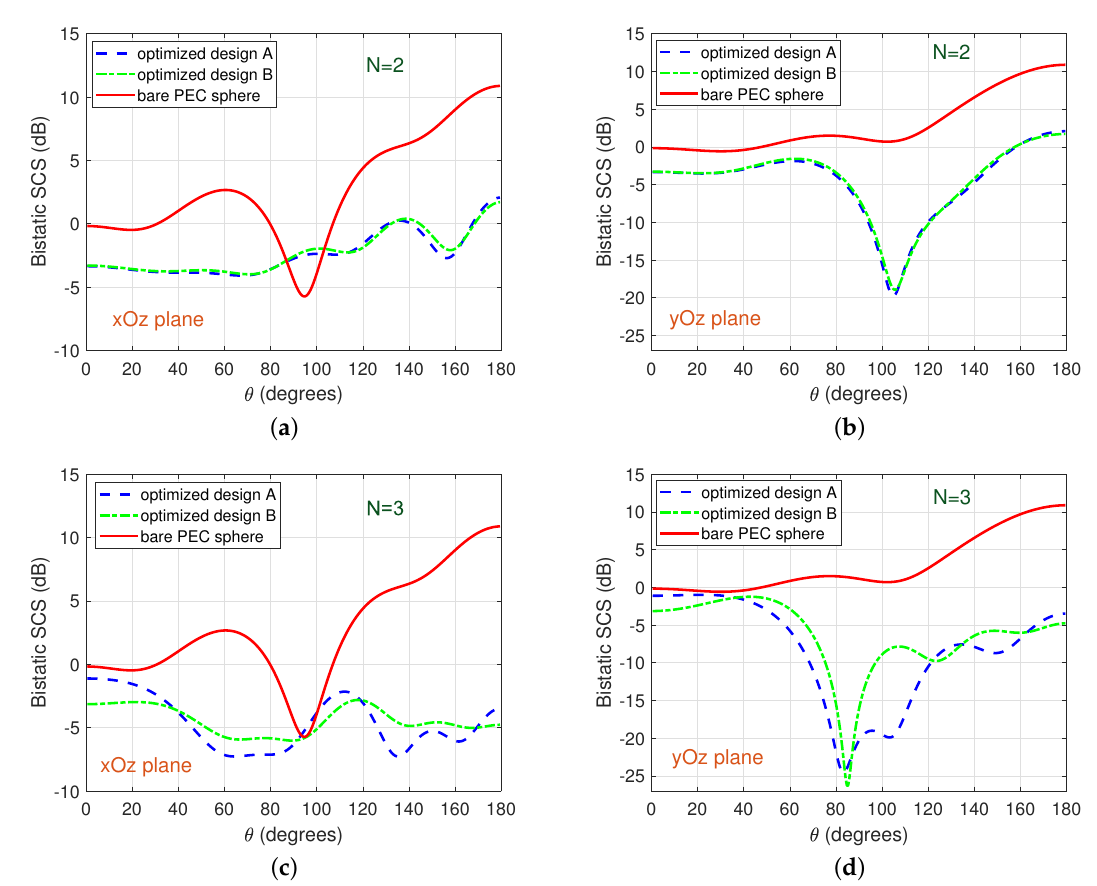
Figure 5. Normalized bistatic SCS σ ( θ , φ ) / ( π a 2 c ) in the xOz and yOz planes versus the angle θ for ( a , b ) N = 2 and ( c , d ) N = 3 optimized spherical shells (layers) covering a PEC core of radius k 0 a c = π excited by a dipole at b = 10 a c (nearly plane-wave incidence case). The values of the optimization variables for designs A and B are given in Table A3 of